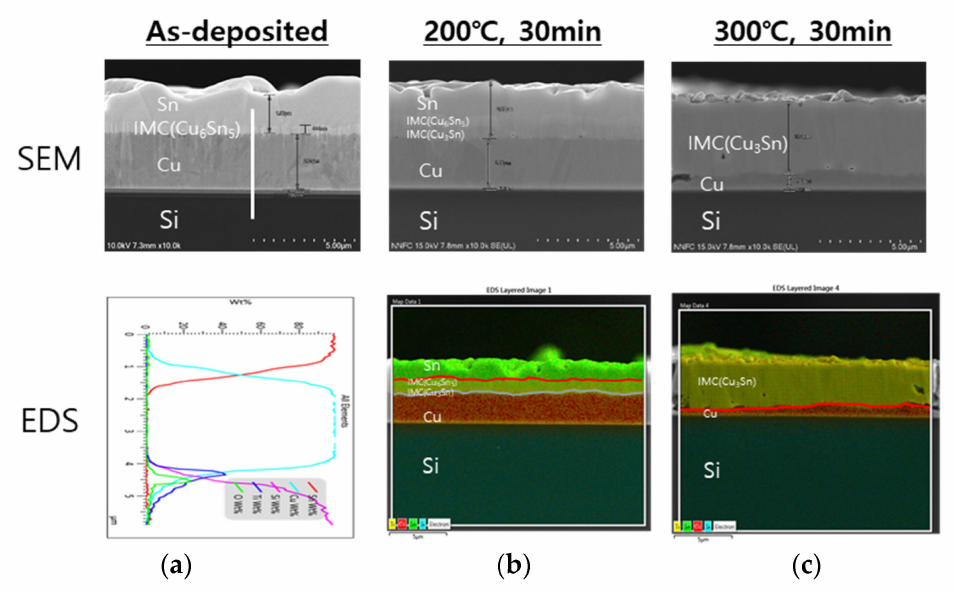
Figure 4. SEM and EDS analysis results of Cu-Sn diffusion couples on a Si substrate ( a ) as-deposited or with annealing ( b ) at 200 ◦ C or ( c ) 300 ◦